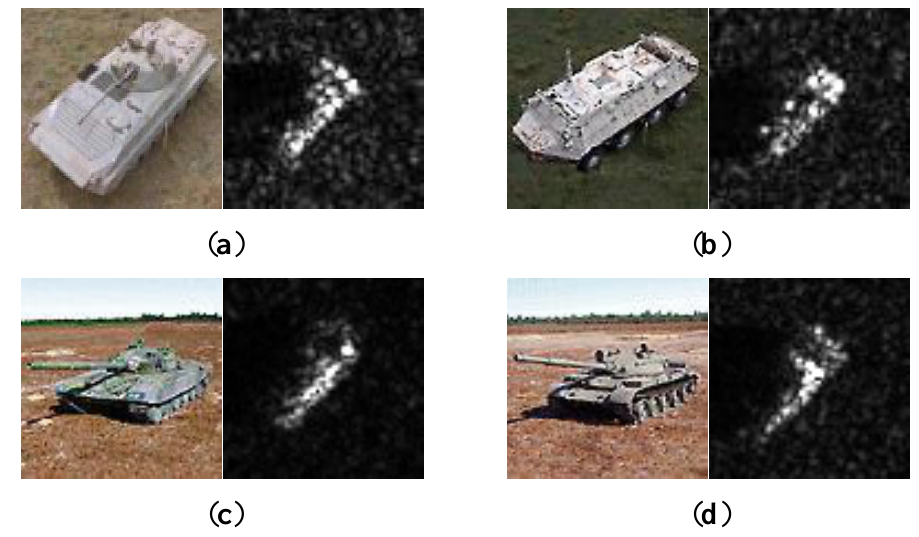
Figure 7. Illustration of four-class target: ( a ) BMP2; ( b ) BTR60; ( c ) T72; and( d ) T62.